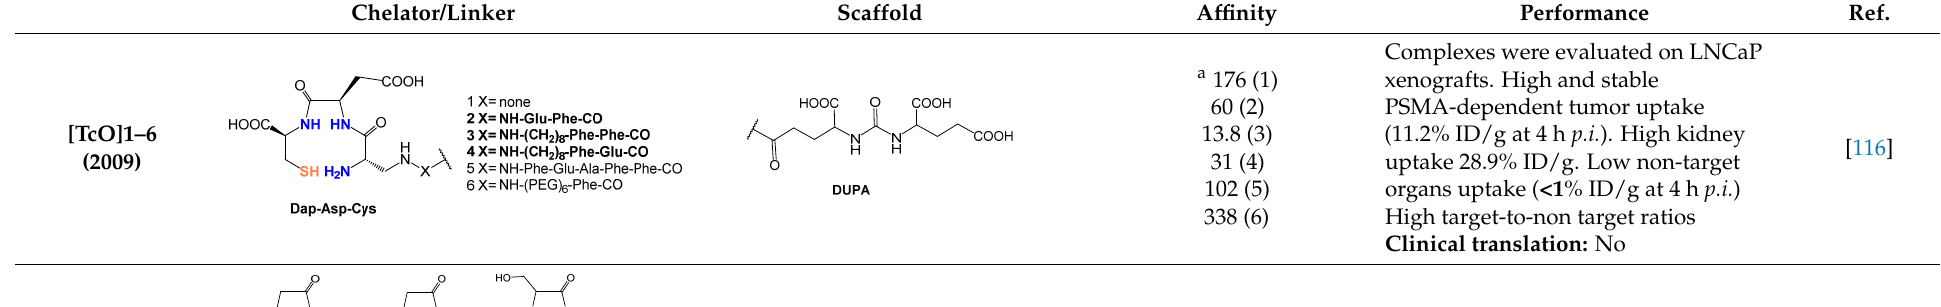
Table 5. PSMA-i labeled with [ 99m Tc][TcO] 3+ -core. Chelator/Linker